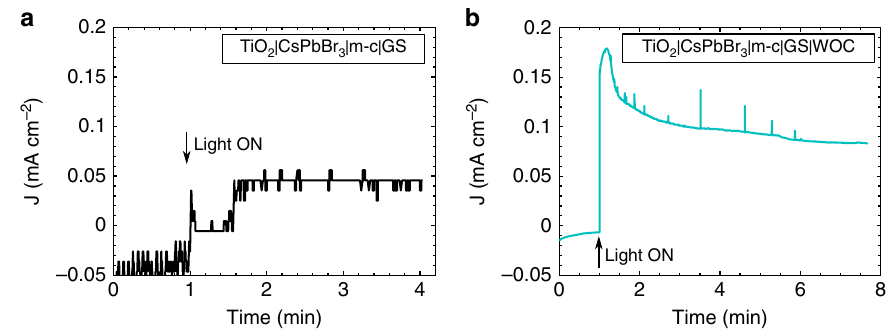
Fig. 9 Unbiased two-electrode performance of TiO 2 |CsPbBr 3 |m-c|GS and TiO 2 |CsPbBr 3 |m-c|GS|WOC. a Chronoamperometric trace of TiO 2 |CsPbBr 3 |m-c| GS recorded in a two-electrode cell. b Chronoamperometric trace of TiO 2 |CsPbBr 3 |m-c|GS|WOC recorded in a two-electrode cell (0.1 M KNO 3 with pH adjusted to 2.5 with H 2 SO 4 , with no external bias voltage